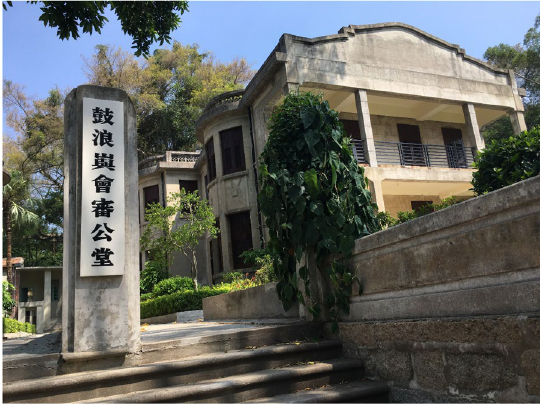
Fig. 3 The former Kulangsu Mixed Court, 2018 (Source: the